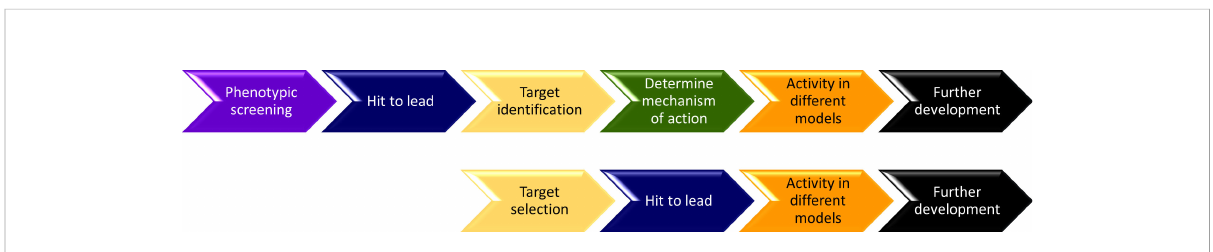
FIGURE 4 A schematic diagram of the steps during development of dengue NS4B inhibitors (upper panel). Lower panel shows the steps needed to develop NS4B inhibitors using a target-based drug discovery approach.